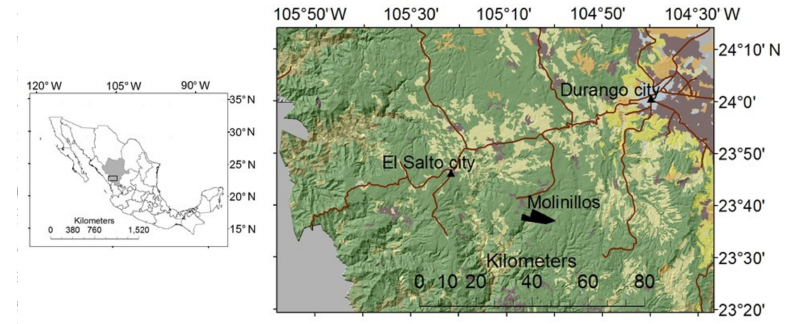
Figure 1. Location of the Molinillos private property in the state of Durango,